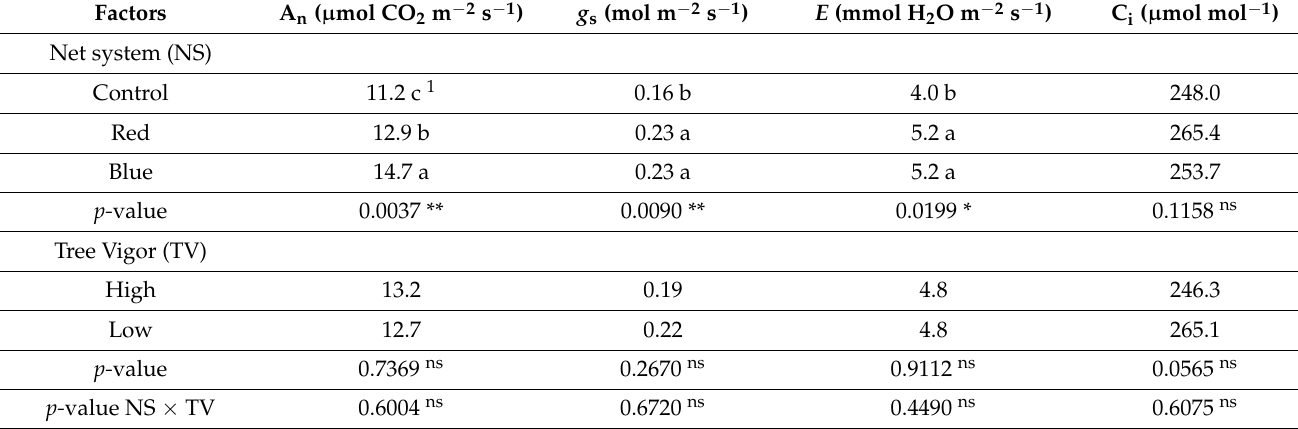
Table 4. The influence of red and blue netting and tree vigor on net photosynthesis rate ( A n ), stomatal conductance ( g s ), transpiration rate ( E ) and intercellular carbon dioxide concentration (C i ) in ‘Fuji’ apple leaves measured under controlled light